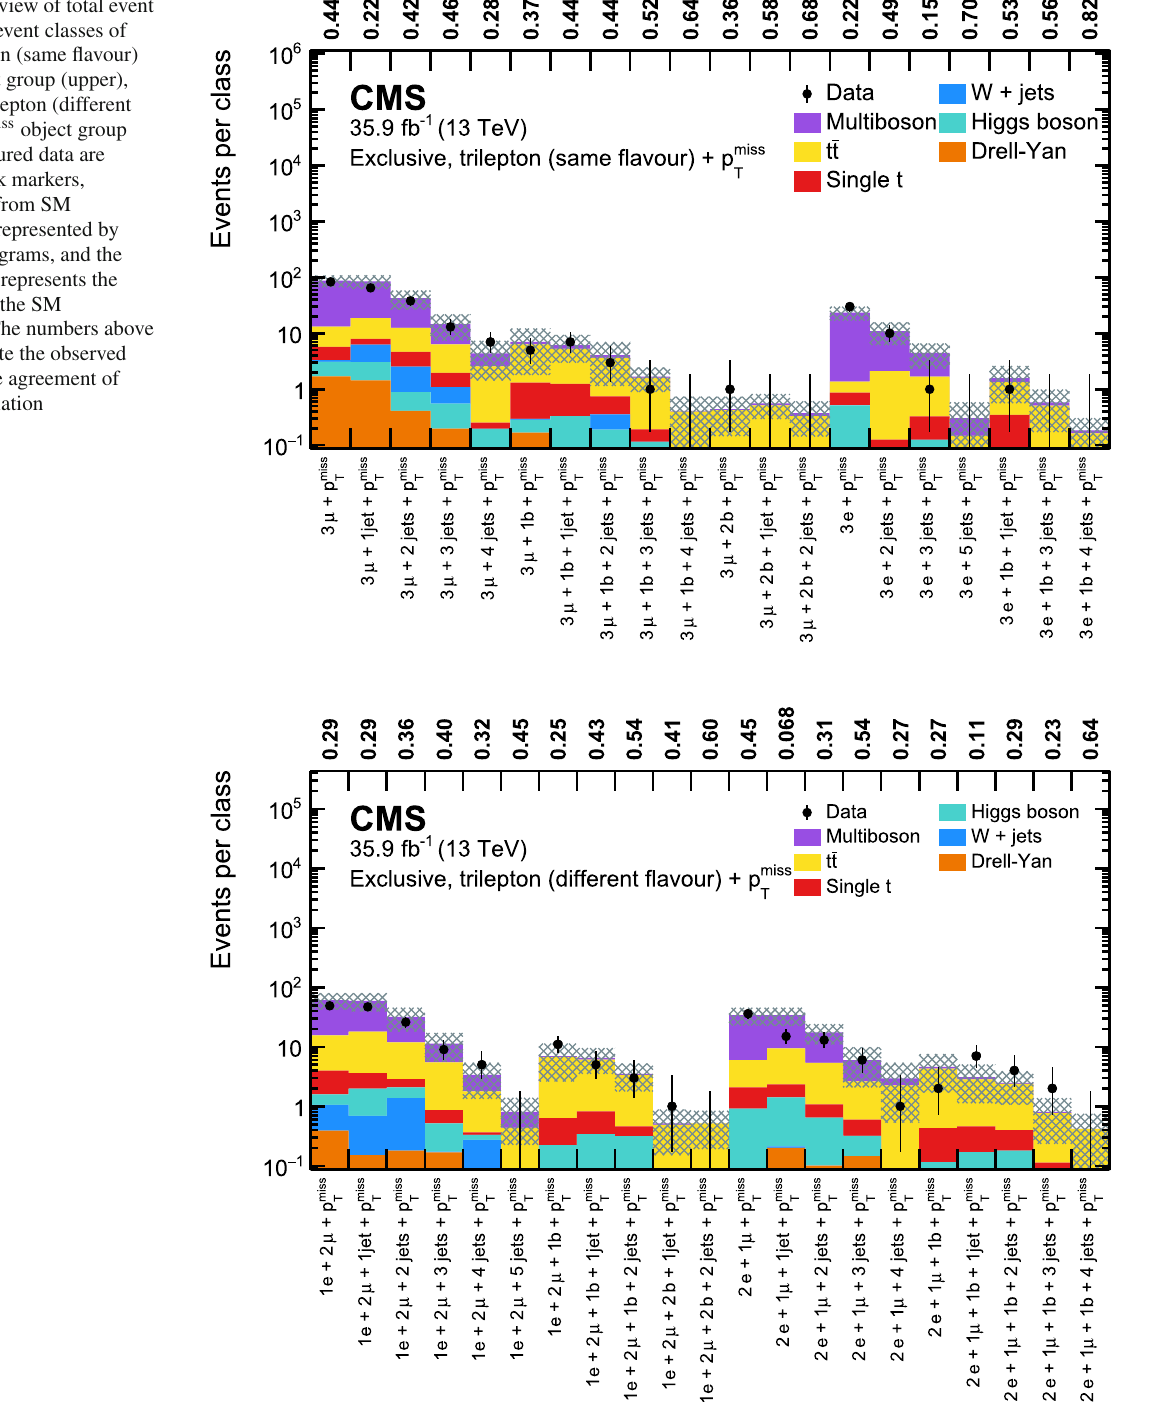
Fig. 21 Overview of total event yields for the event classes of the three-lepton (same flavour) + p miss object group (upper), T and the three-lepton (different flavour) + p miss object group T (lower). Measured data are shown as black markers, contributions from SM processes are represented by coloured histograms, and the shaded region represents the uncertainty in the SM background. The numbers above the plot indicate the observed p value for the agreement of data and